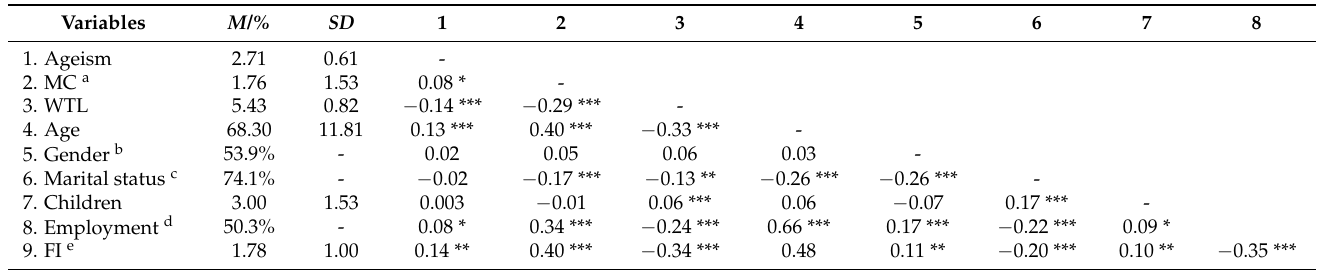
Table 1. Descriptive statistics for the study ( n =